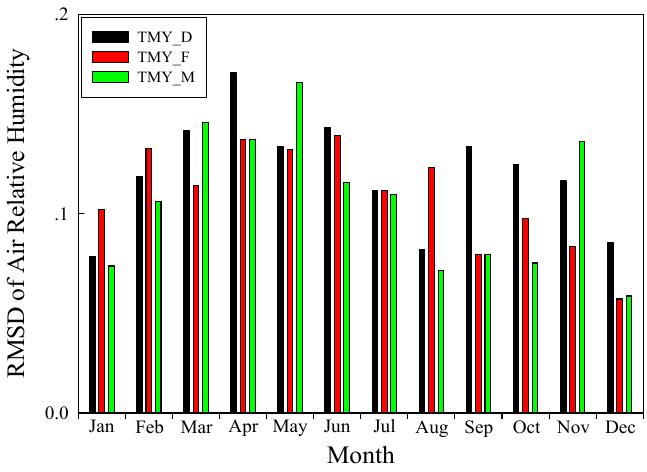
Figure 4. RMSD results of air relative humidity by the three methods in Lhasa.